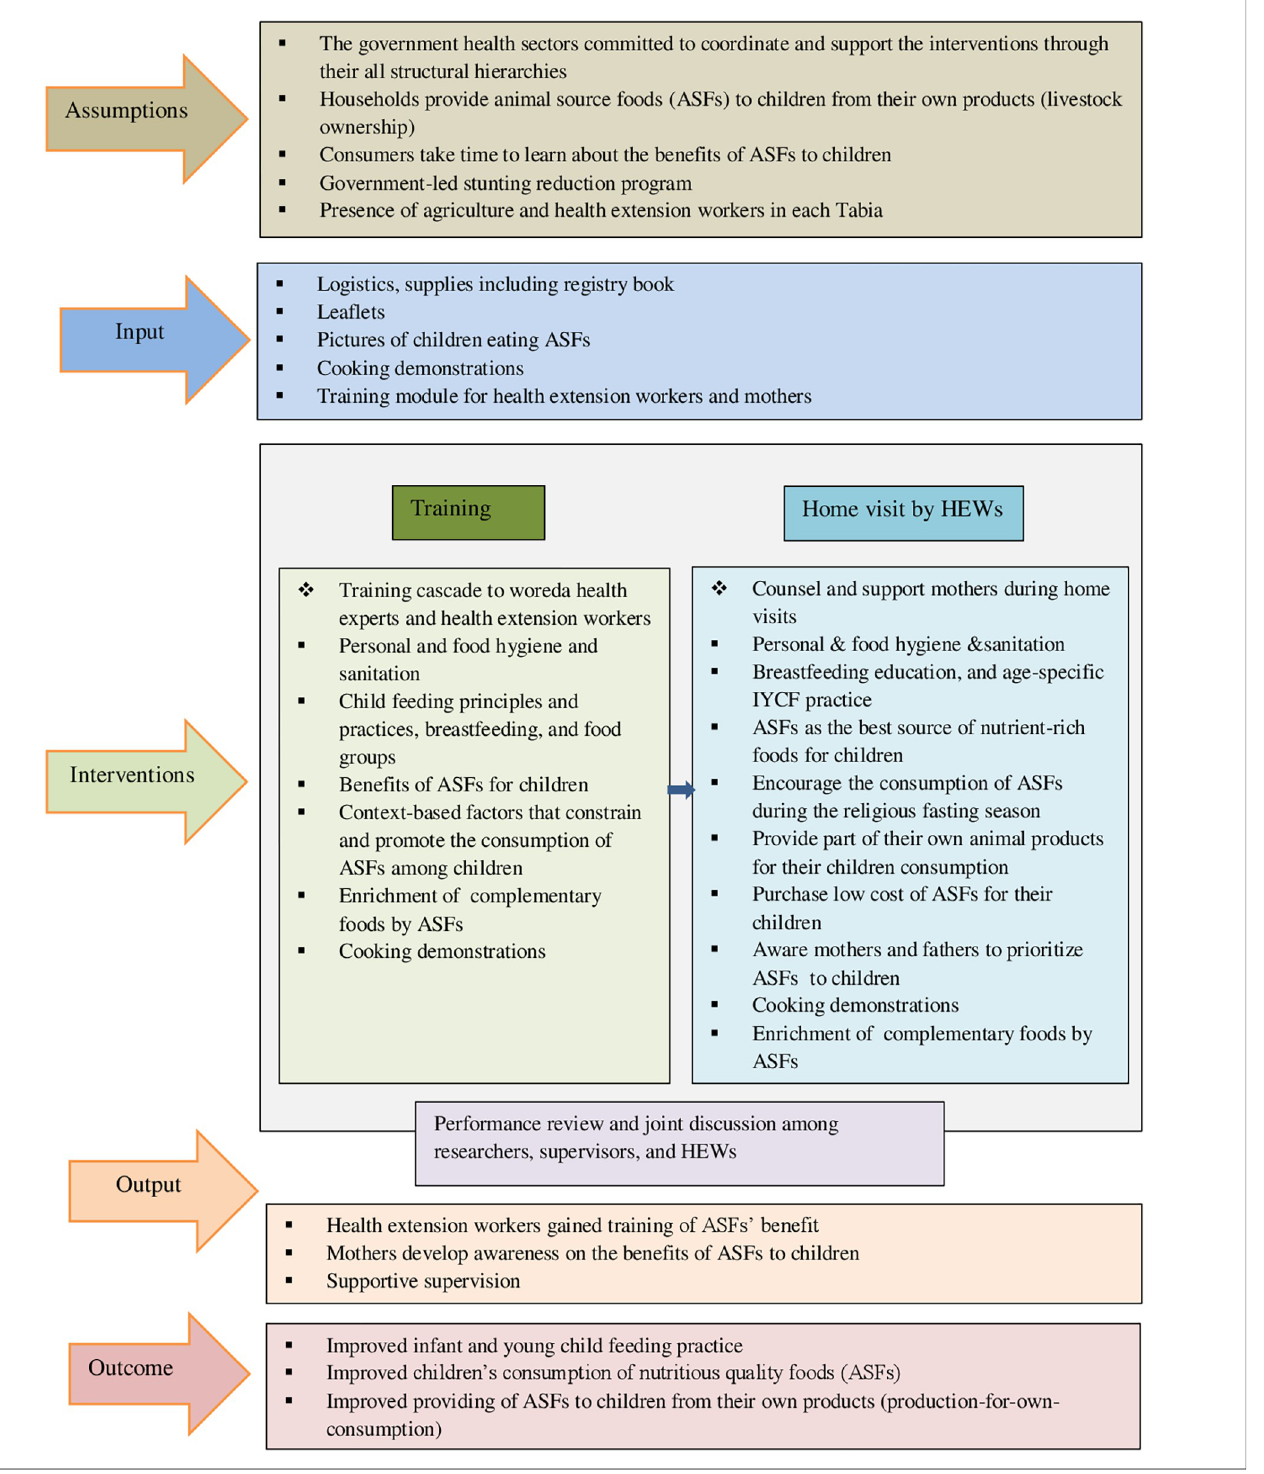
Fig 2. Logic framework of nutrition education interventions for optimizing the consumption of ASFs among young children in selected districts of Northern Ethiopia.